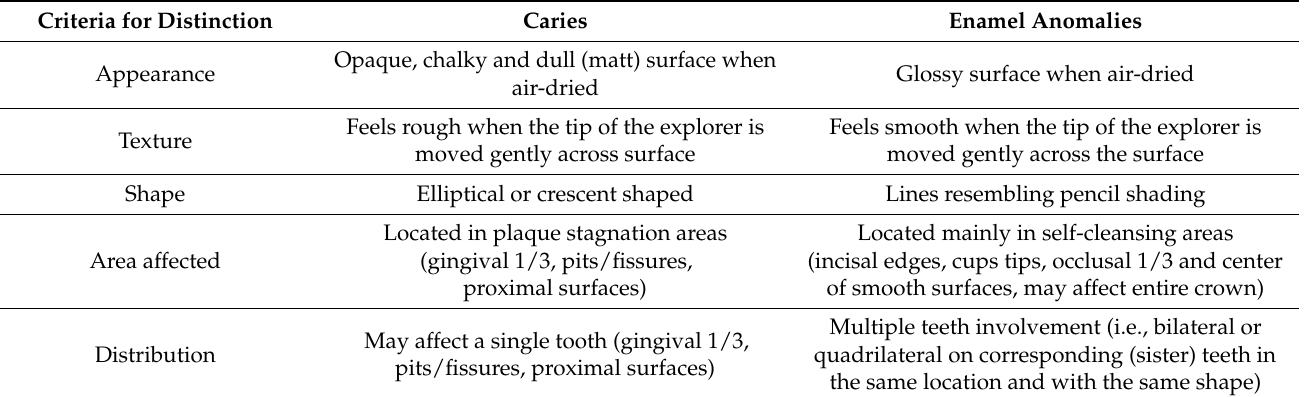
Table 2. Differentiating the causes of white spot lesions as caries versus enamel